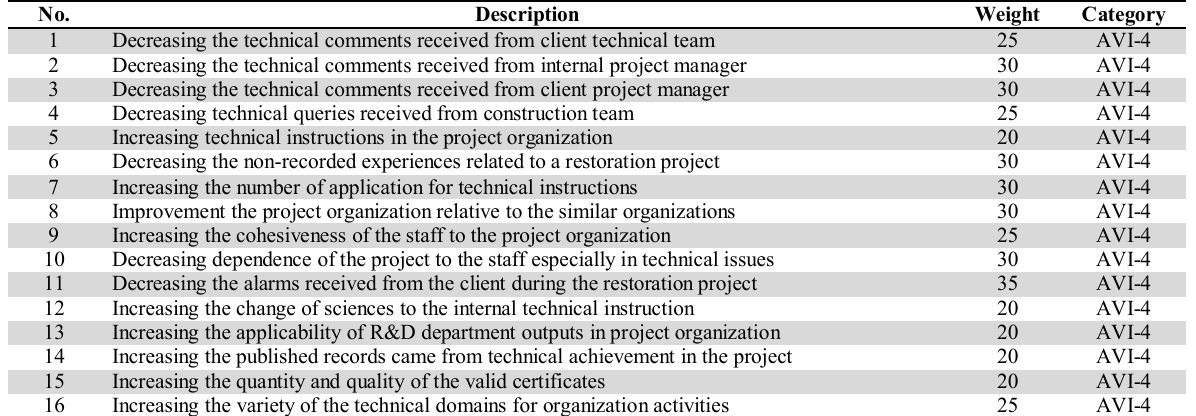
Part four of the characteristics that affect added values come from knowledge management implementation in the project organization; used in the case